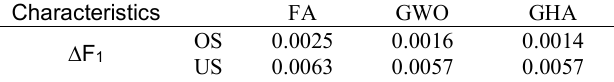
Table 2. (b) Comparison of system dynamic responses with various